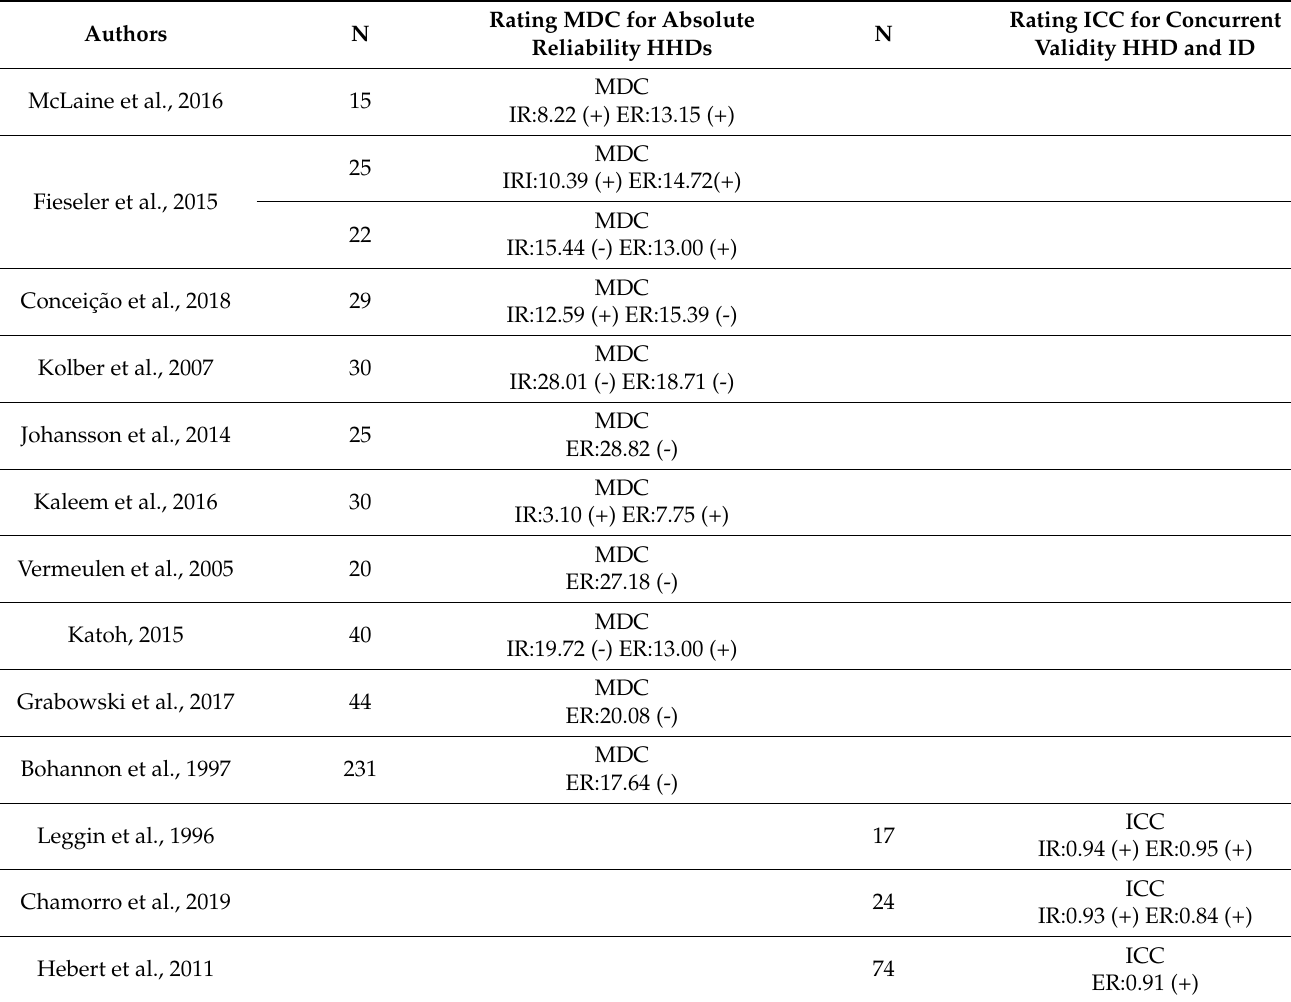
Table 7. Methodology of studies analyzing absolute reliability of HHD and concurrent validity between HHDs and ID based on the criteria for good measurement